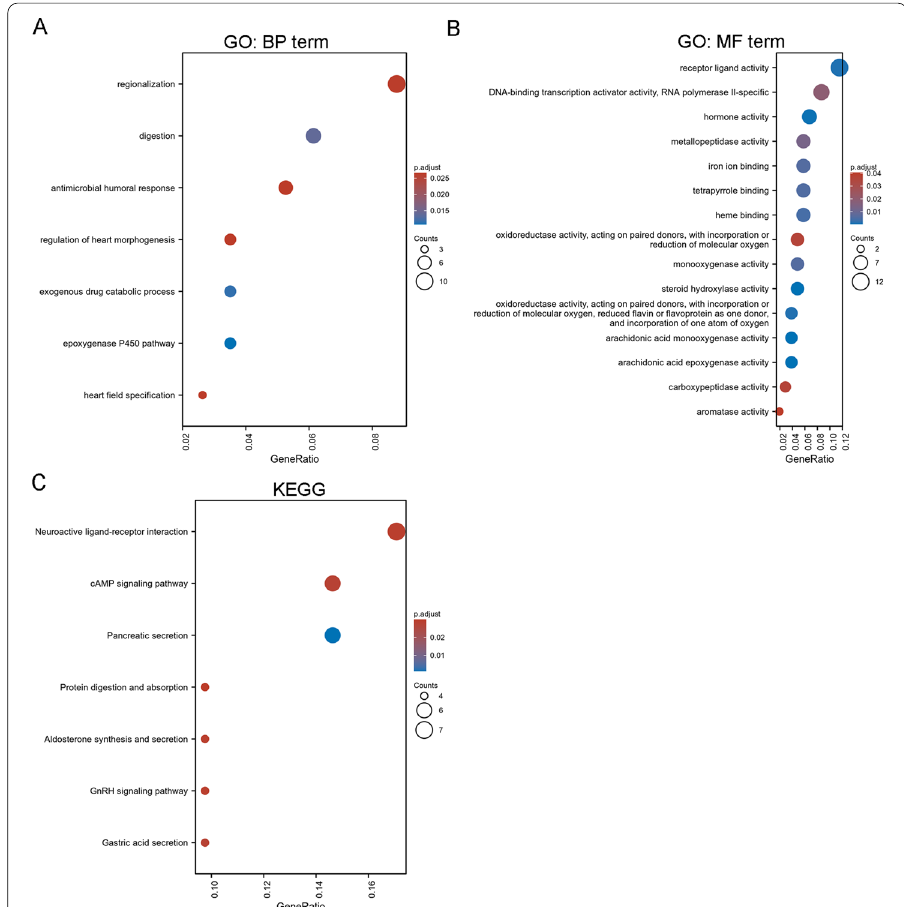
Fig. 7 GO and KEGG analysis. ROBO1 -related top 100 up-regulated and down-regulated genes were used to perform GO [BP terms ( A ) and MF terms ( B )] and KEGG analysis ( C